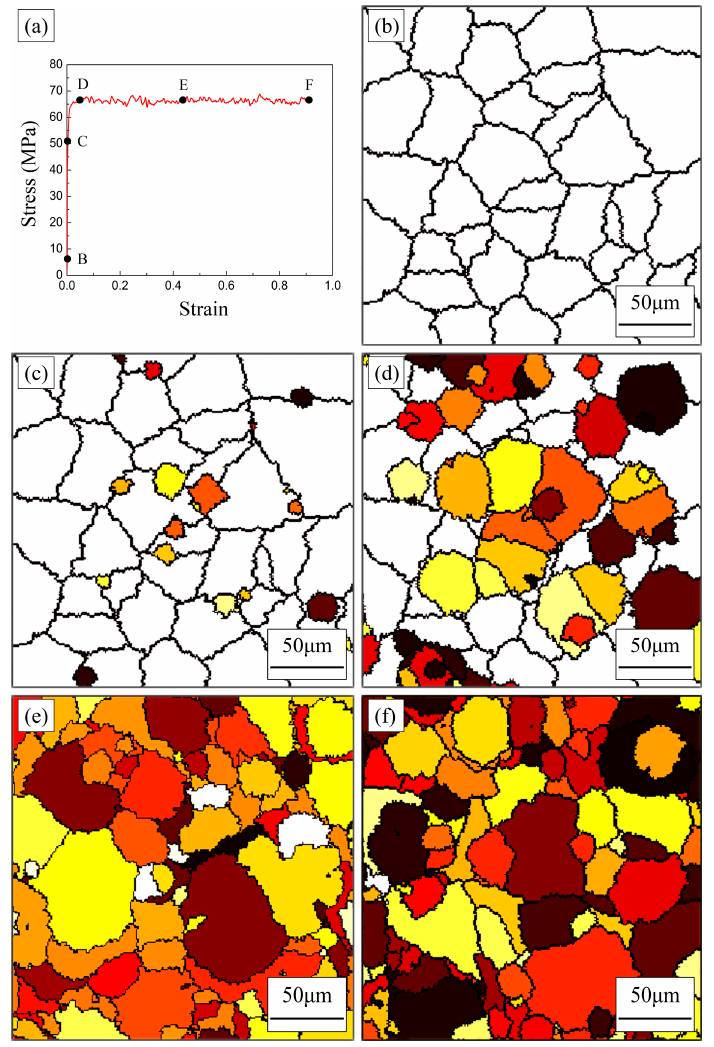
Figure 2. Microstructural evolution of FeMnSiCrNi SMA undergoing compression (T = 1000 ◦ C, ε = 0.005 s − 1 ) based on CA simulation: ( a ) Stress-strain curve; ( b ) point B in ( a ); ( c ) point C in ( a ); ( d ) point D in ( a ); ( e ) point E in ( a ); ( f ) point F in ( a ).